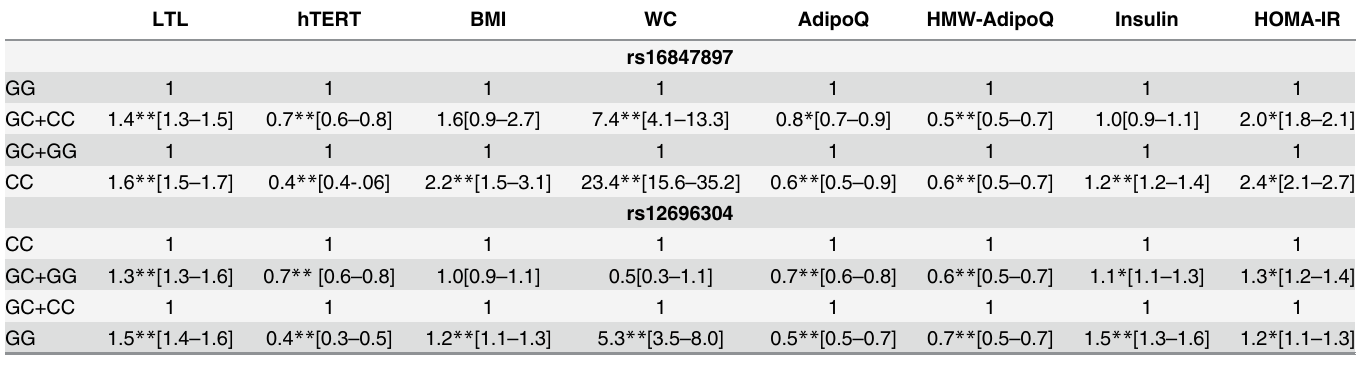
Table 3. ORs [95CI] for associations of TERC SNPs rs16847897 and rs12696304 with LTL, hTERT, anthropometric indices and metabolic factors of obesity.